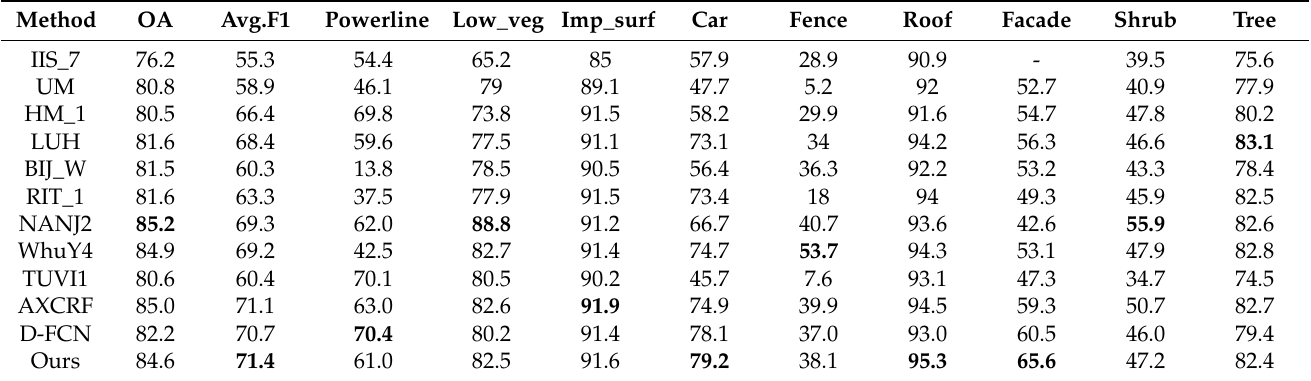
Table 5. Quantitative comparison of performance between our method and other methods on the Vaihingen 3D dataset. The highest scores are typed in